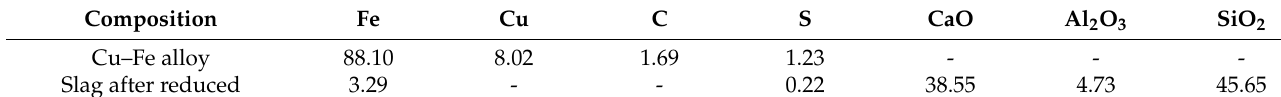
Table 1. The composition of Cu–Fe alloy and slag after reduced (wt.%).